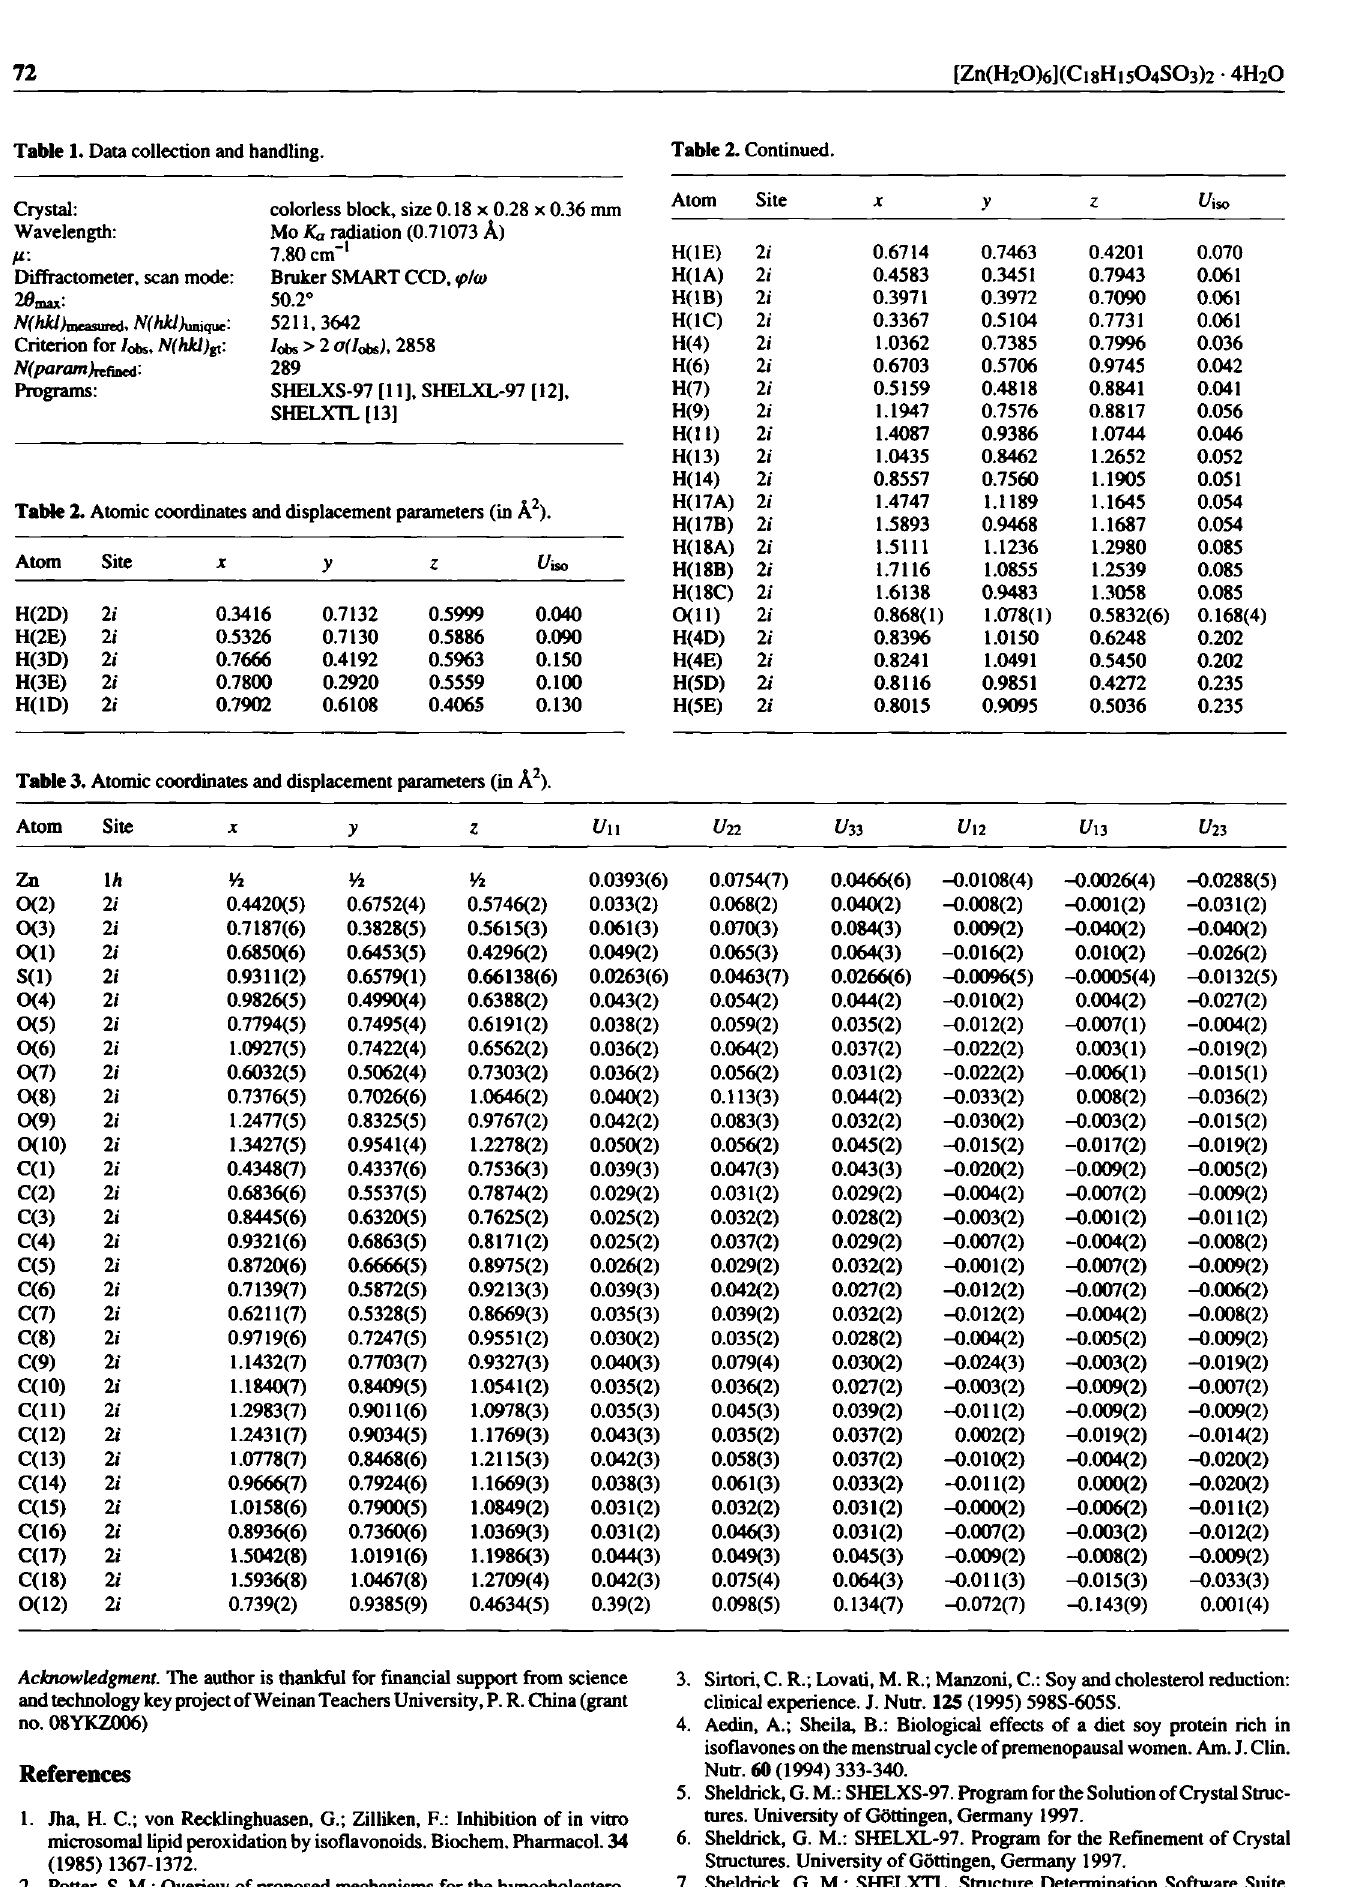
Table 1. Data collection and handling.